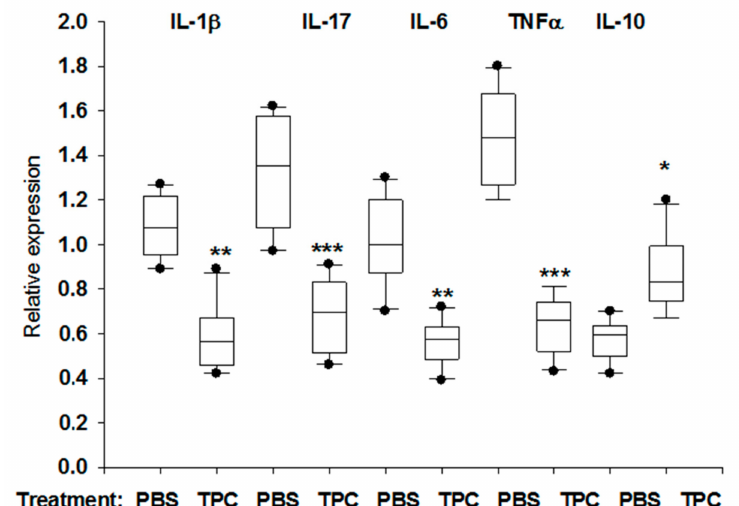
Figure6. CytokinesgeneexpressionofIL-1 β , IL-17, IL-6, TNF α , IL-10bymesentericlymphnodes(MLN) from oral administration of tuftsin–phosphorylcholine (TPC) in comparison to phosphate-bu ff ered saline (PBS) subjected mice. The data was normalized with β -Actin expression. One Asterix p < 0.001, two Asterix p < 0.02-0.03, three Asterix p <